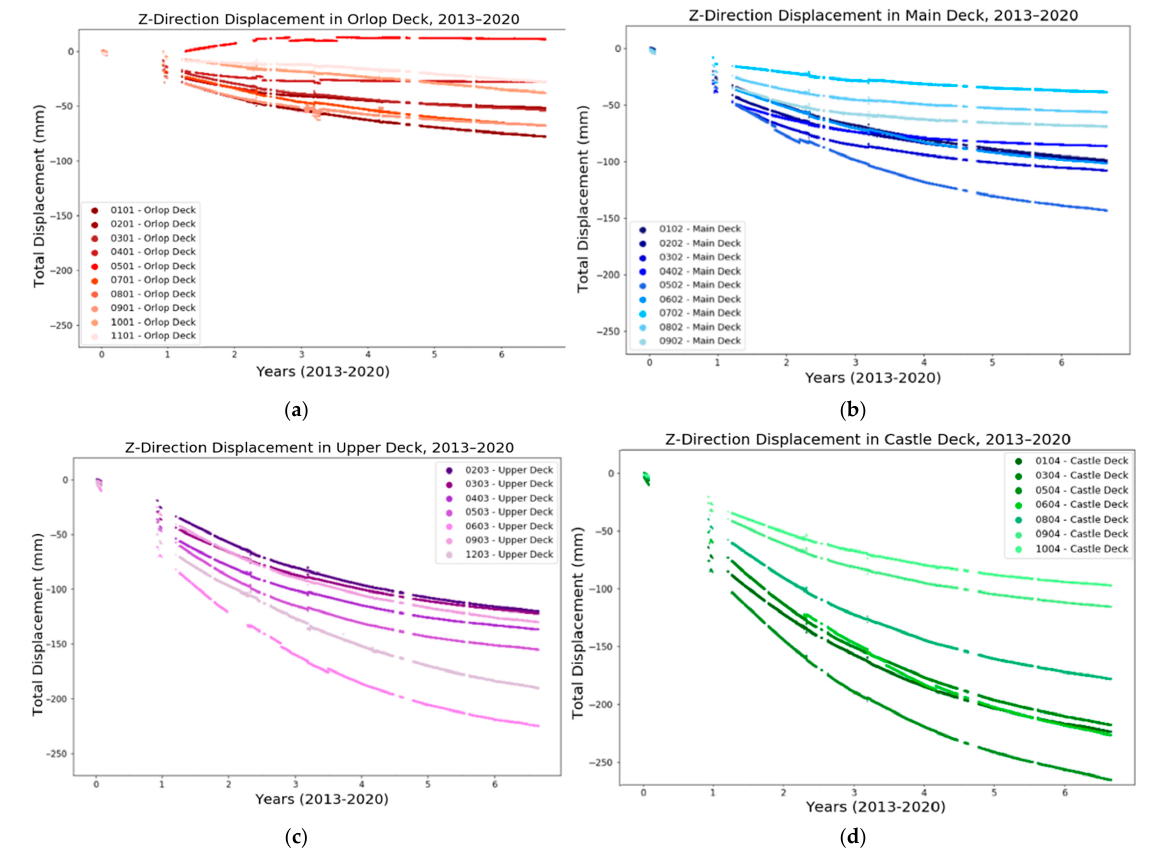
Figure 5. Z direction displacement of the TS targets in the ( a ) orlop, ( b ) main, ( c ) upper and ( d ) castle decks plotted against time for the period between September 2013 and March 2020.